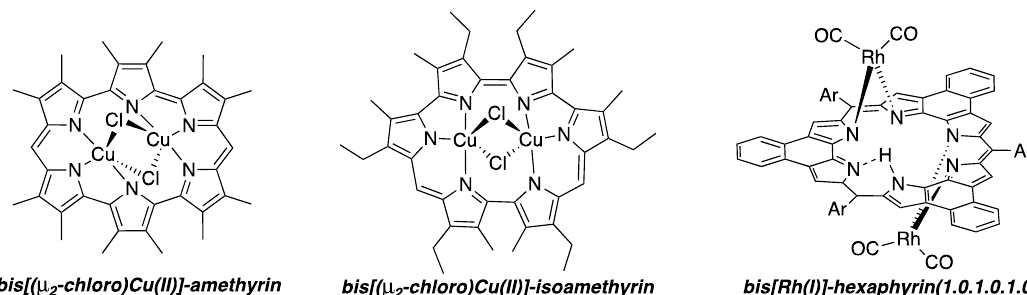
Figure 1. Representative binuclear hexaphyrin complexes.